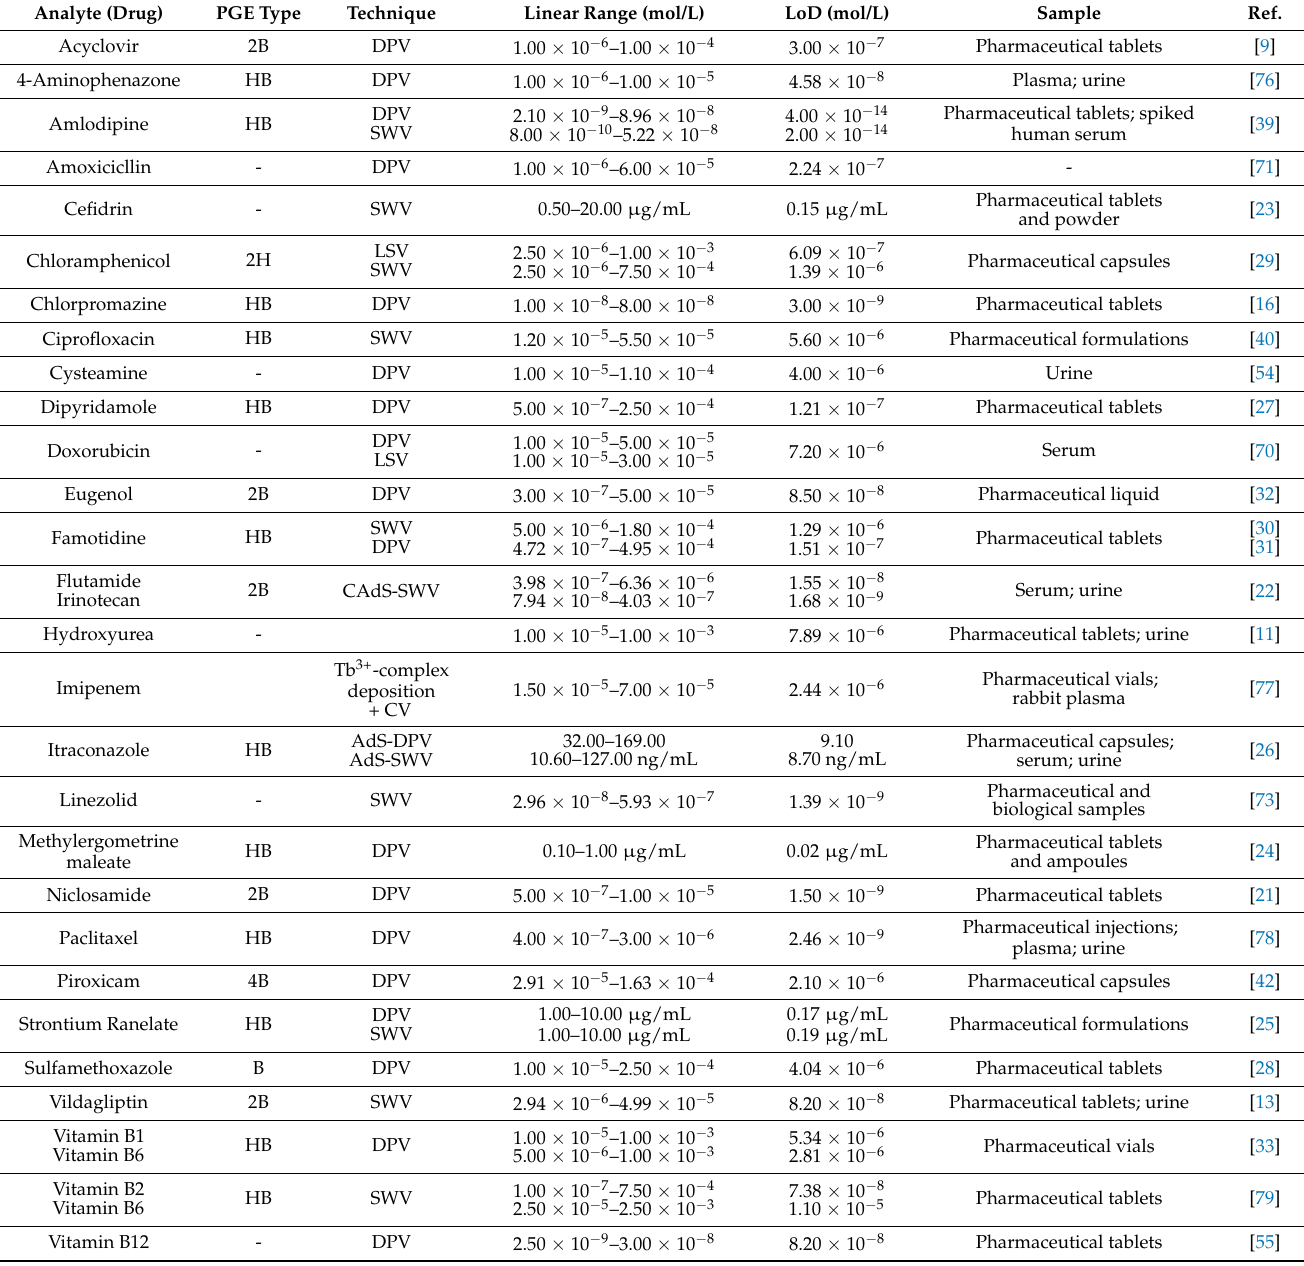
DPV = differential pulse voltammetry; SWV = square wave voltammetry; LSV = linear sweep voltammetry; CAdS- SWV = cathodic adsorptive stripping square wave voltammetry; CV = cyclic voltammetry; AdS-DPV = adsorptive stripping differential pulse voltammetry; AdS-SWV = adsorptive stripping square wave